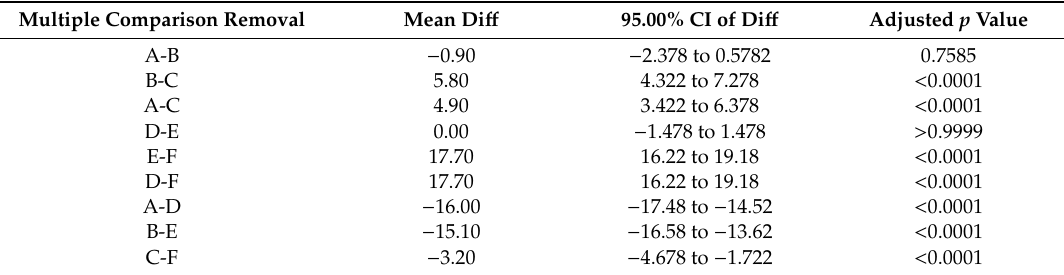
Table 4. Removal ANOVA Bonferroni post hoc groups